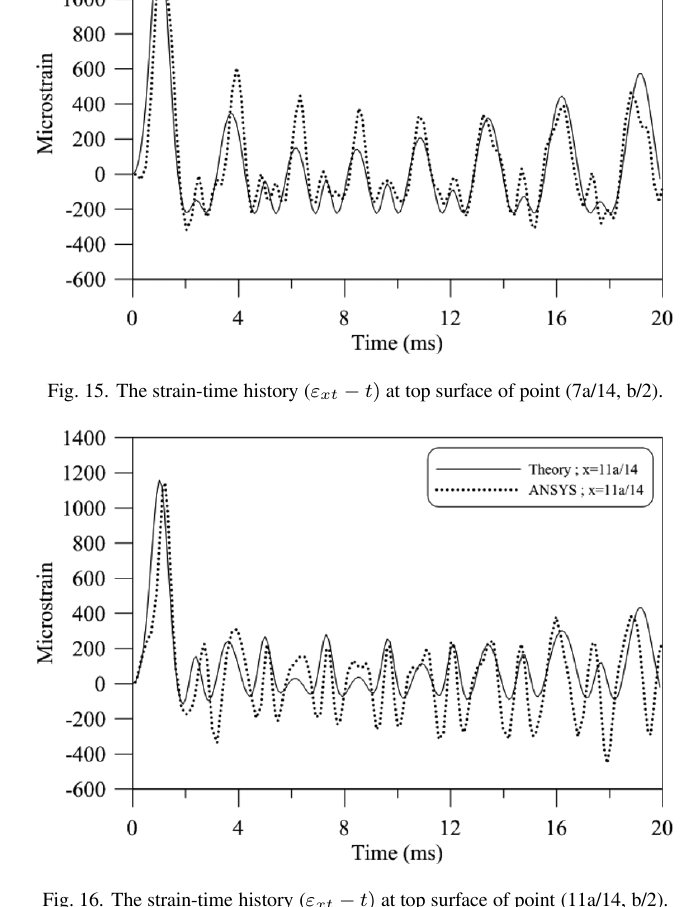
Fig. 16. The strain-time history ( ε xt − t ) at top surface of point (11a/14, b/2).